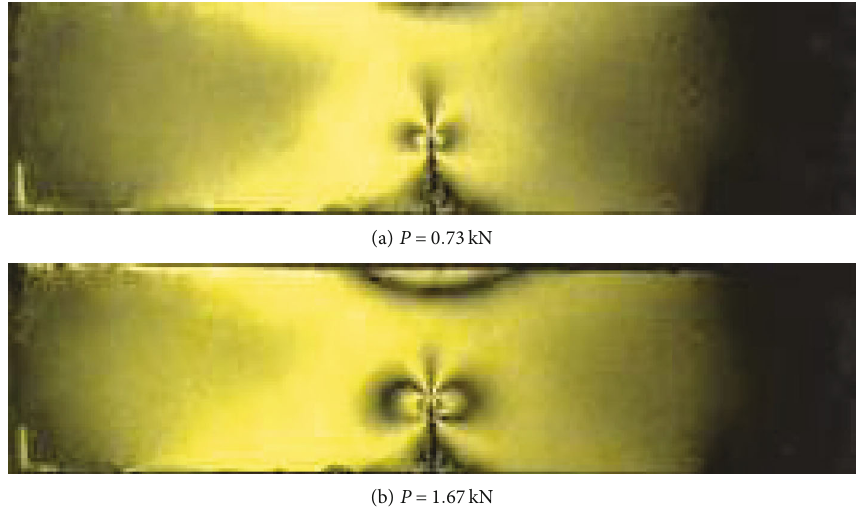
Figure 3: Crack propagation displayed by coatings (specimen 0-2).